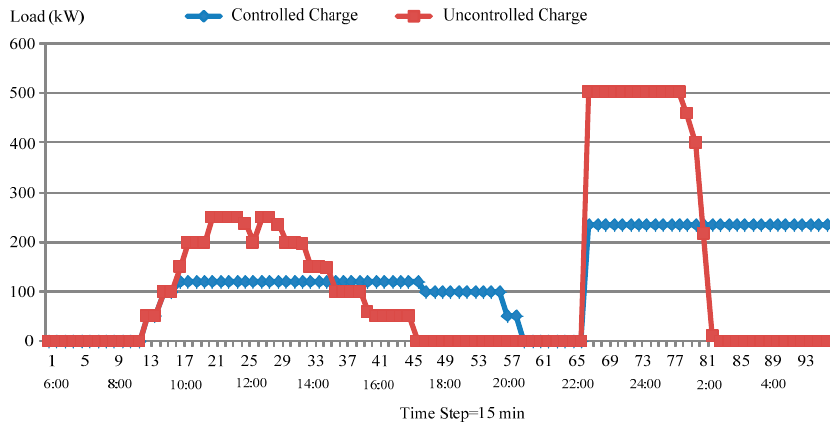
Figure 10. Charging station load profile for this iteration.